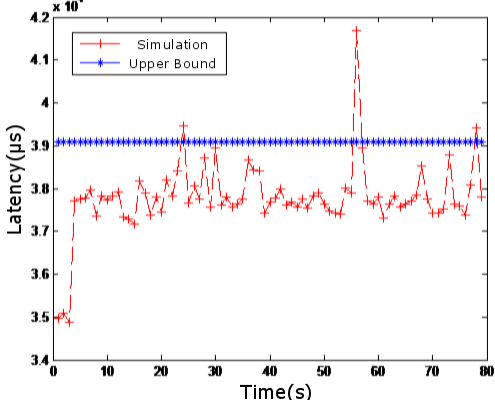
Figure 9. Results superimposing competing flows in BC-pAug89 data set.